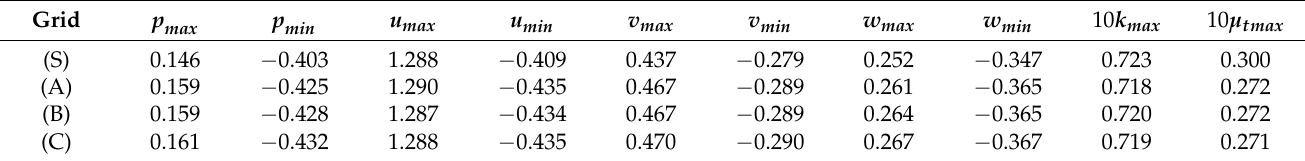
Table 3. Extreme flow parameter values and the turbulence characteristics for different density grids. Grid p